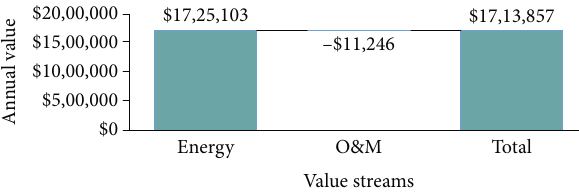
Figure 8: Categorized annual